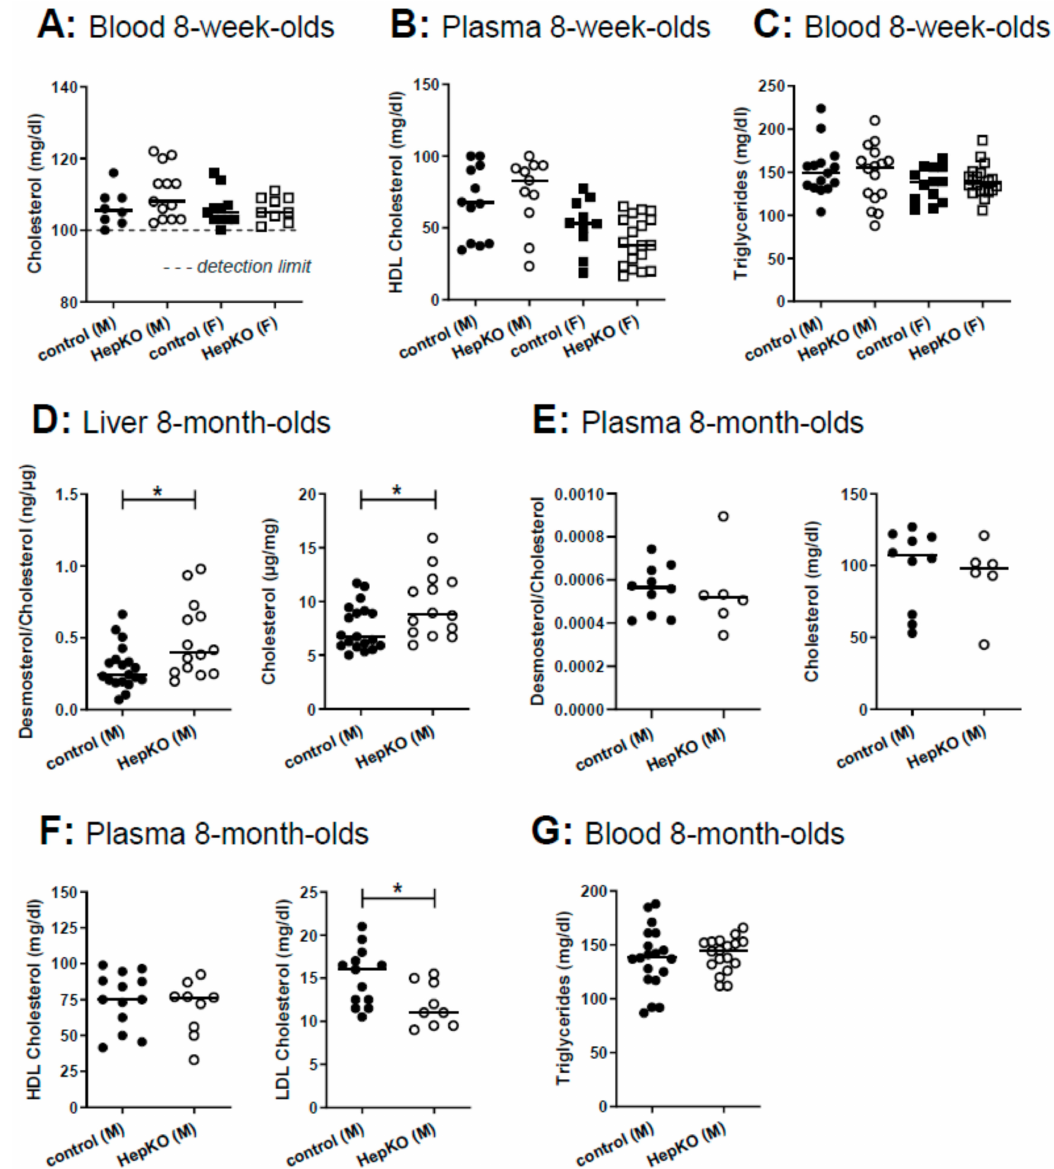
Figure 5. Cholesterol and triglyceride content in liver and plasma of Sgpl1 HepKO mice. Total cholesterol (whole blood, A ), HDL cholesterol (plasma, B ) and triglycerides (whole blood, C ) were measured in 8 week old mice using a Reflotron analyser. ( D – G ) Cholesterol and triglycerides in 8 month old mice. ( D , E ) Cholesterol and its precursor desmosterol were determined by gas chromatography-flame ionization detection and gas chromatography-mass spectrometry, respectively, in liver ( D ) and plasma ( E ). Desmosterol is expressed as fold cholesterol. ( F ) HDL and LDL cholesterol in plasma were determined photometrically. ( G ) Triglycerides were determined in whole blood using a Reflotron analyser. Shown are values from individual mice and their median ( A , n = 8–13; B , n = 10–19; C , n = 13–20; D , n = 14 and 19; E , n = 6 and 10; F , n = 9 and 13; G , n = 18 and 19). * p < 0.05 in two-tailed Student’s t